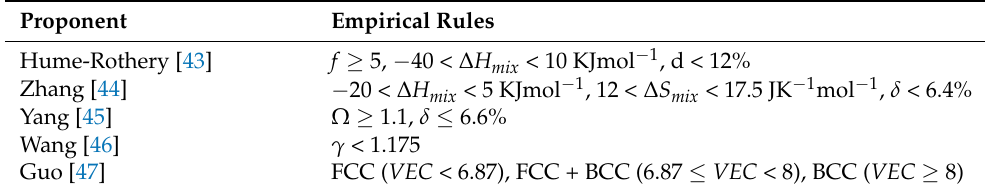
Table 2. Formation criteria of solid solution of HEAs.